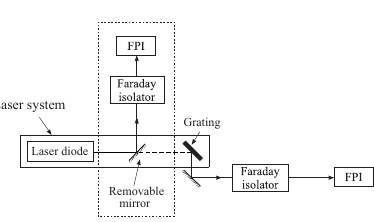
Figure 6. Experimental setup for measurement of the laser linewidth using a FPI. The grating in the ECDL cavity is bypassed by inserting a mirror attached to a removable mount so that the linewidth of the free running laser diode can be determined. This configuration is shown by the dotted box. When the mirror is removed, the linewidth of the laser is much smaller ( ∼ 1 MHz) due to the presence of grating feedback. Since the FPI resolution is ∼ 60 MHz, only the instrument limited linewidth is measured in this case.